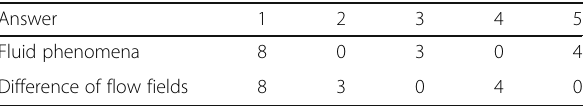
Table 3 Total number of answers of participants based on the five-point Likert